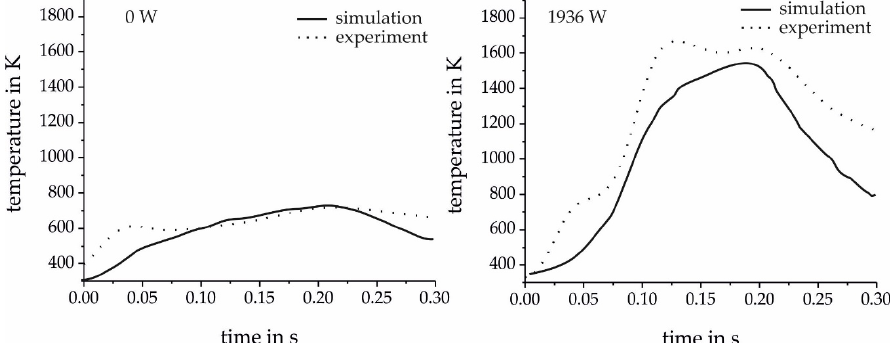
Figure 18. Comparison of numerical and experimental results of the temperature distribution in steel sheet of 0 W and 1936 W magnet power.